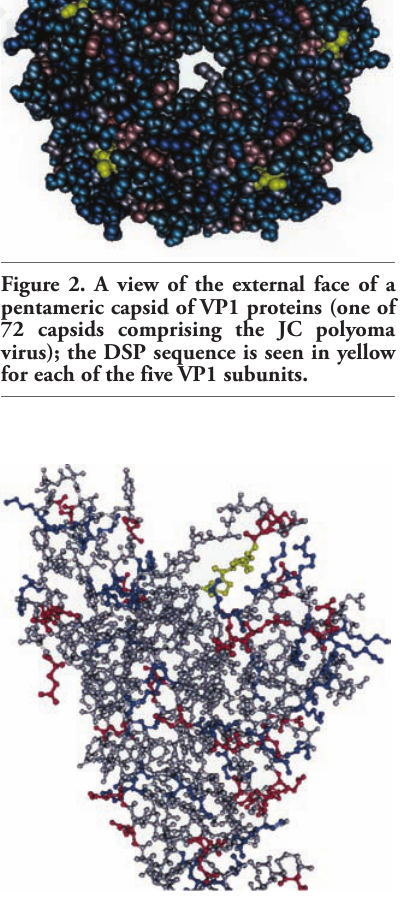
Figure 3. The VP1 protein as a ball and stick representation colored according to charge, with yellow indicating the DSP sequence homologous to the IDSP sequence mediating VCAM-1 binding to the alpha 4 integrin